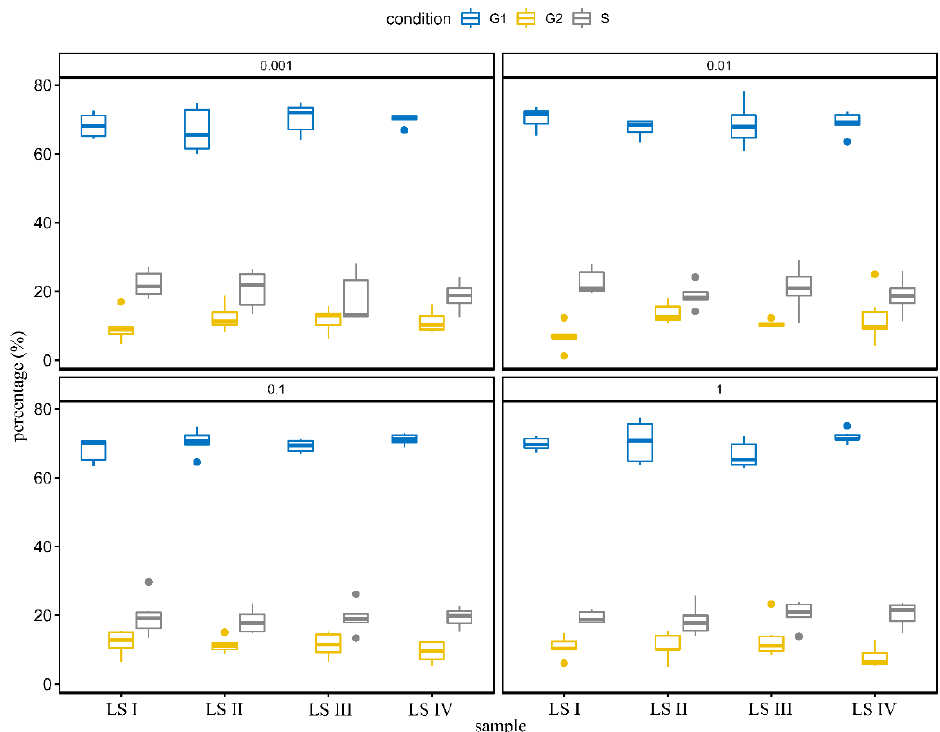
Figure 4. Cell cycle assay of tested soaps (LS I − base; in following soaps addition of 4% ( w/w ) surfactants: LS II − cocamidopropyl betaine; LS III − addition of cocamidopropyl hydroxysultaine; LS IV − addition of evening primroseamidopropyl sulfobetaine). Results were presented as median with quartiles (25% and 75%), n = 6, three independent experiments.